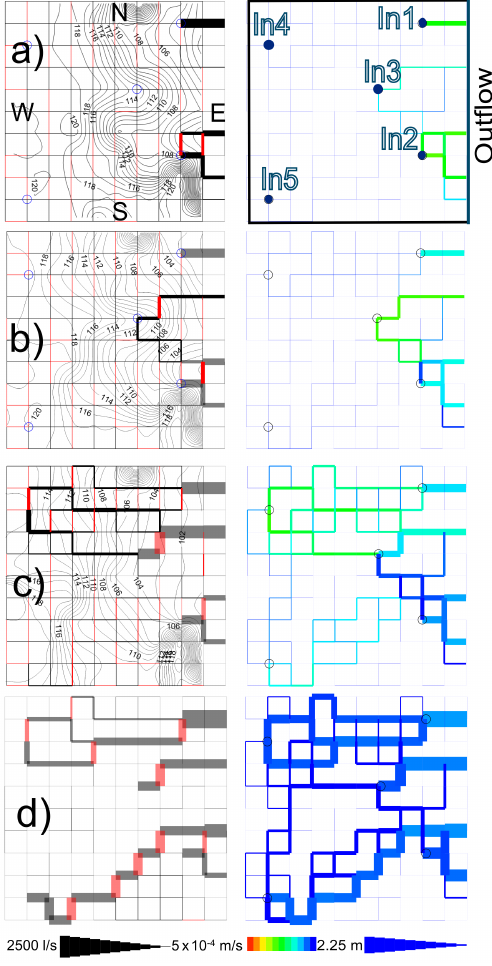
Figure 11. Evolution of a low-dip network with randomly dis- tributed initial